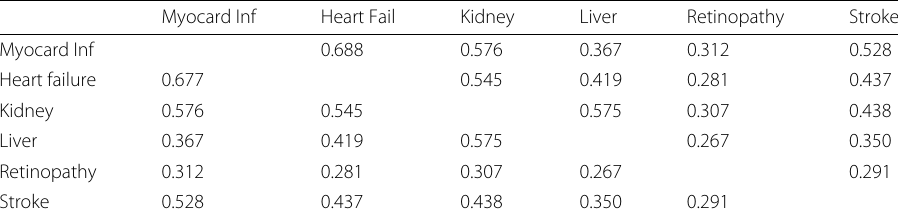
Table 9 Correlations between fast progressors of each complication Myocard